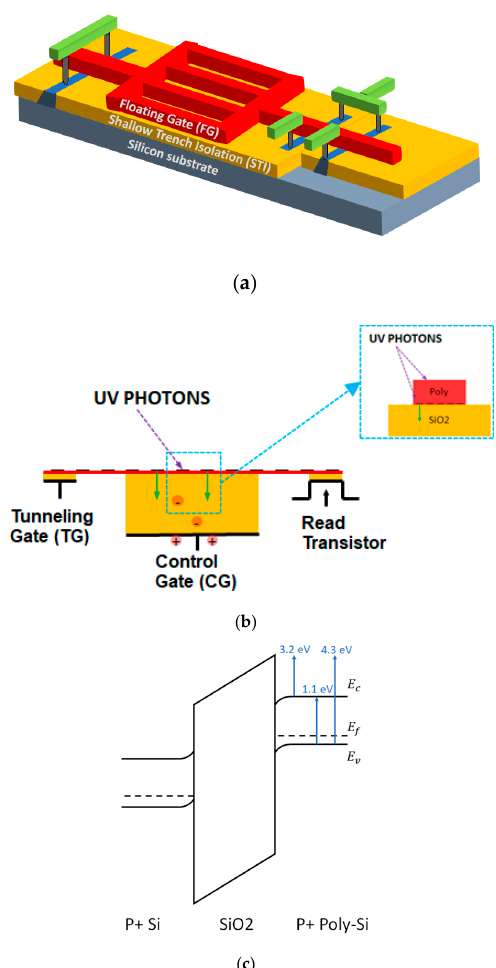
Figure 2. ( a ) Three-dimensional (3D) illustration of “grilled” C-Sensor. ( b ) Schematic illustration of the C-Sensor and discharge of Poly FG. ( c ) Band diagram illustrating FG discharge by UVC.